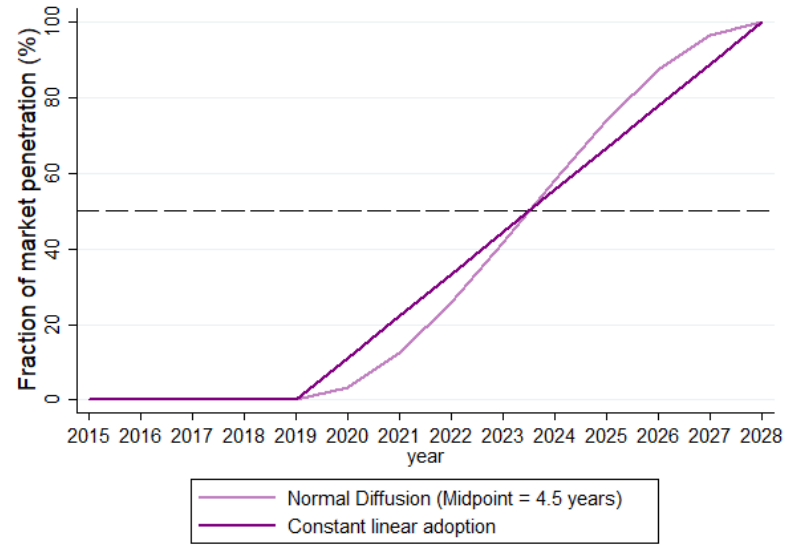
Figure 2. Author’s comparison of linear and s ‐ shaped market diffusion (2019–2028).